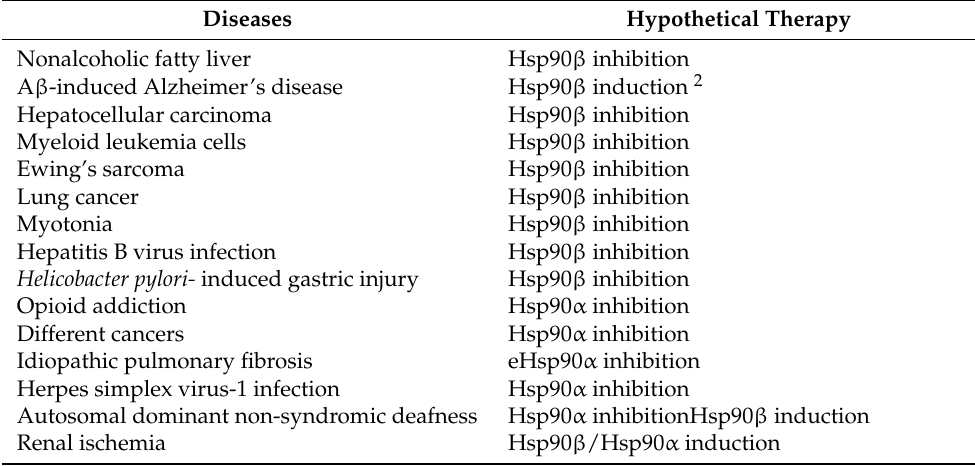
Table 4. Diseases and hypothetical isoform-specific treatments 1 .